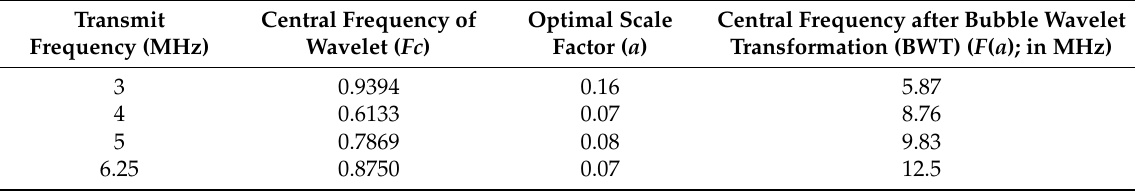
Table 1. The central frequency of the bubble wavelet with different transmit frequencies and their optimal scale